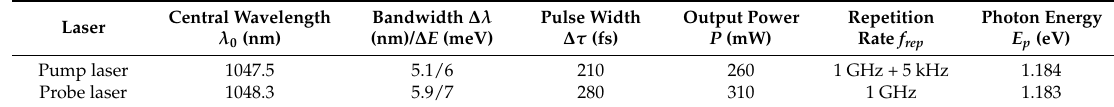
Table 2. Properties of MQW-SESAM sample at a wavelength of λ = 1048.3